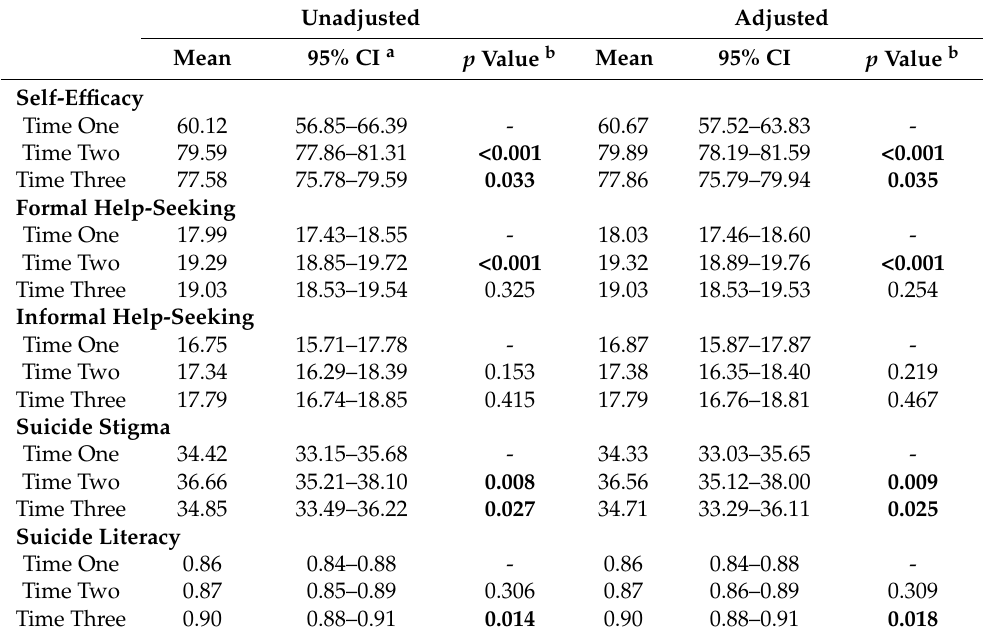
Table 1. Mean scores for outcome variables at each time point based on unadjusted and adjusted multilevel linear regression